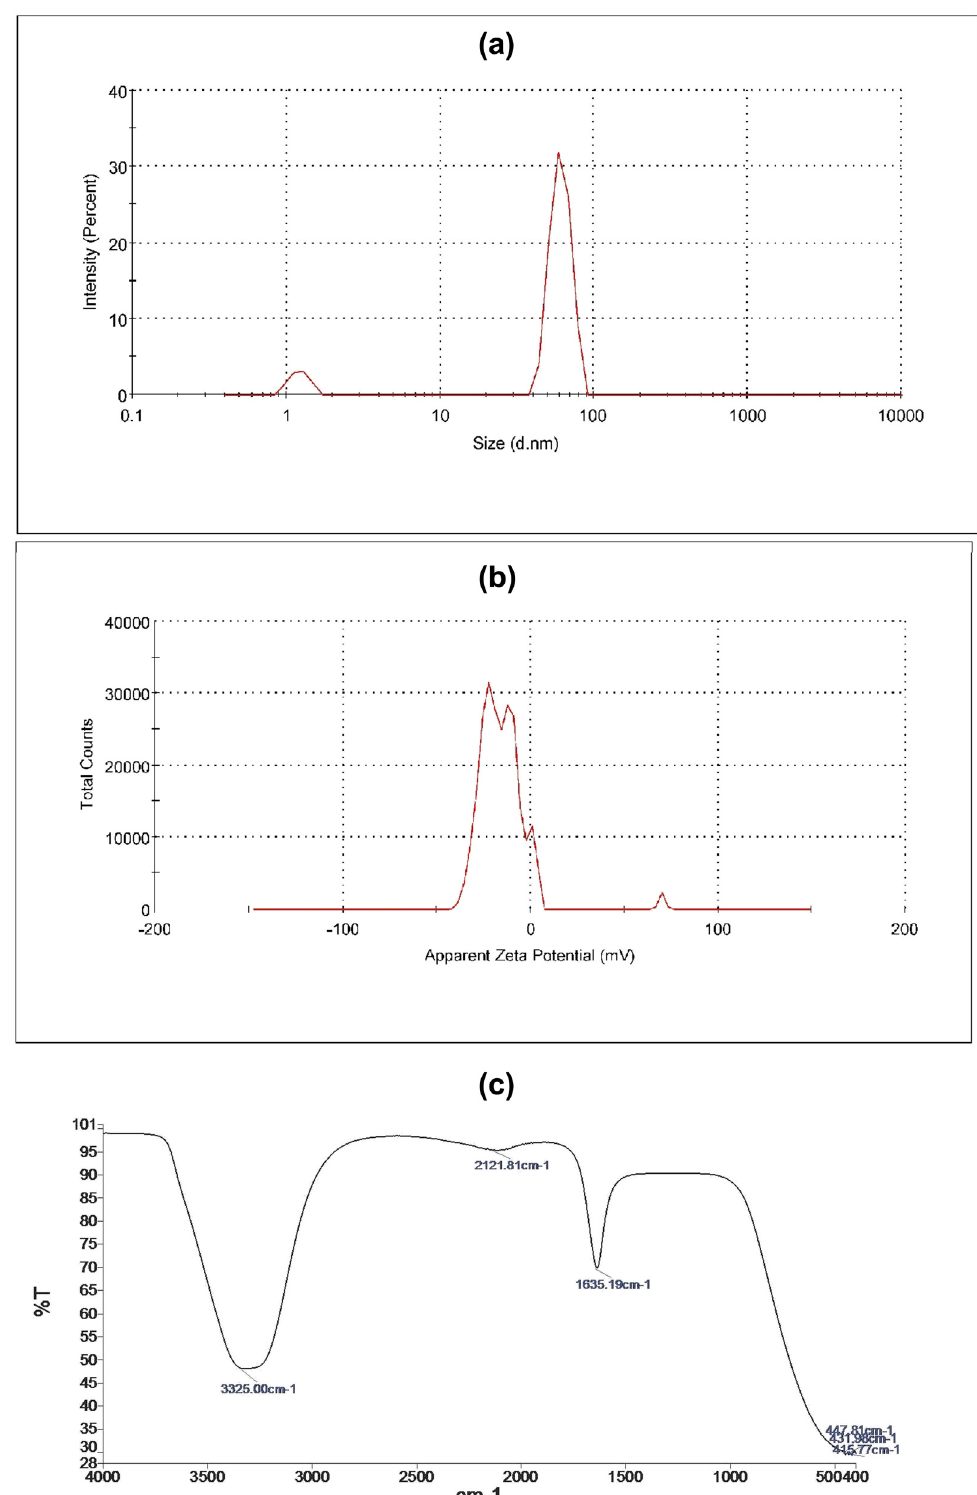
Figure 1: Characteristics of SeNPs coupled with PtE. ( a ) Hydrodynamic diameter of SeNPs - PtE by Zetasizer; ( b ) surface charge of SeNPs - PtE by zeta potential; ( c ) FT - IR spectra of SeNPs - PtE. FT - IR: Fourier transform infrared; SeNPs: selenium